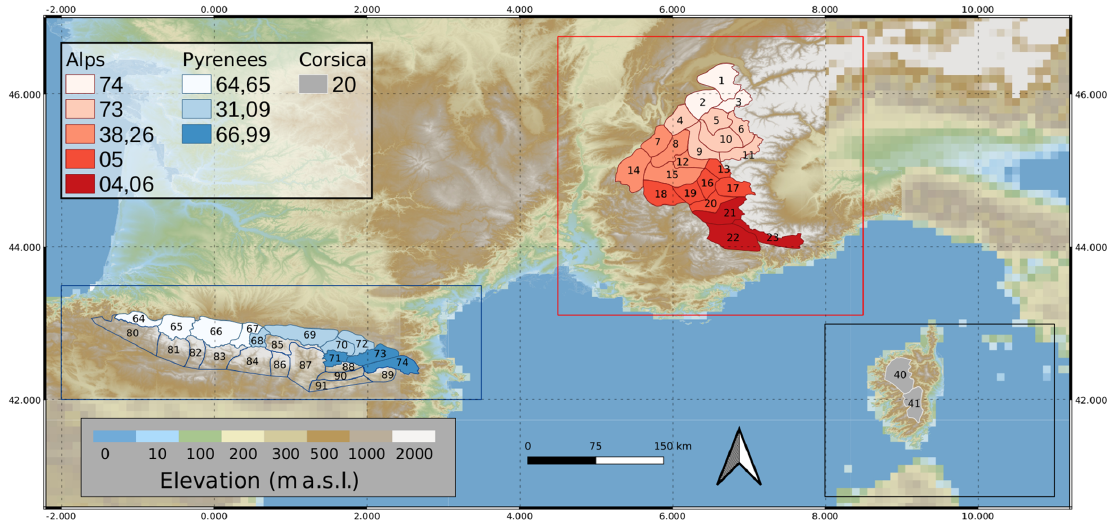
Figure 2. Map of the three areas covered by the S2M reanalysis. The rectangles indicate for each area the domain of extraction of the observations and guess from the NWP output. The numbers within the massifs are the ones used to identify the massifs in the dataset. The color of the massifs indicates the French administrative department(s) in which the largest part of the massif stands. See Table A1 in Appendix A for more